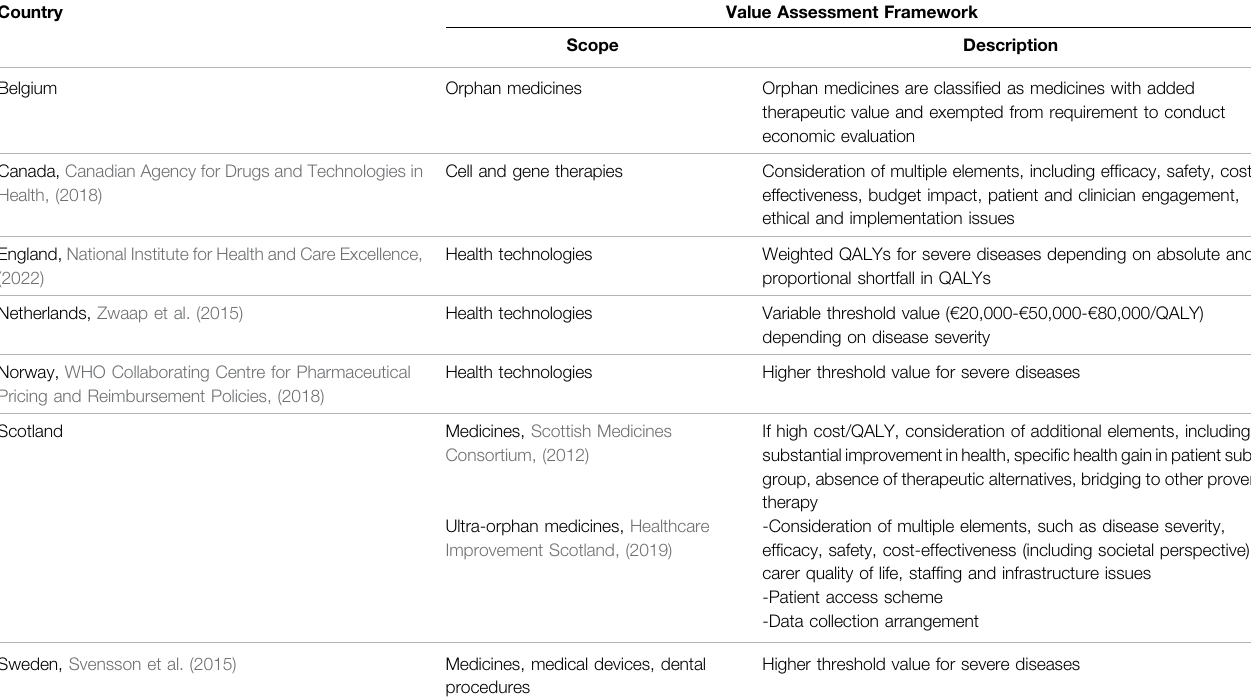
TABLE 2 | Examples of adapted value assessment frameworks that apply to (some) advanced therapies.